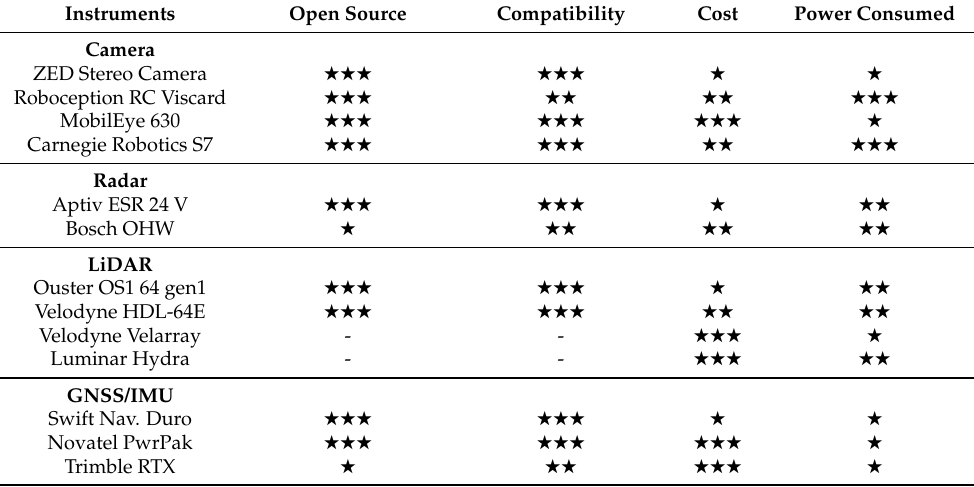
Table 1. Comparison of the open source documentation, the compatibility, the cost, and the power consumption of researched sensors. The symbols represent the information gathered to max out at three symbols showing low ( (cid:72) ), mid ( (cid:72)(cid:72) ), and high ( (cid:72)(cid:72)(cid:72) ).